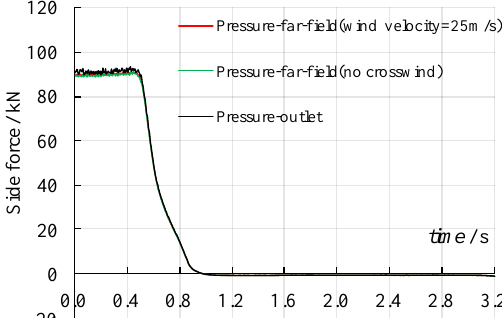
Figure 10. Time-history of the side force of head carriage during the train entering tunnel under three boundary conditions (train speed = 250 km/h).